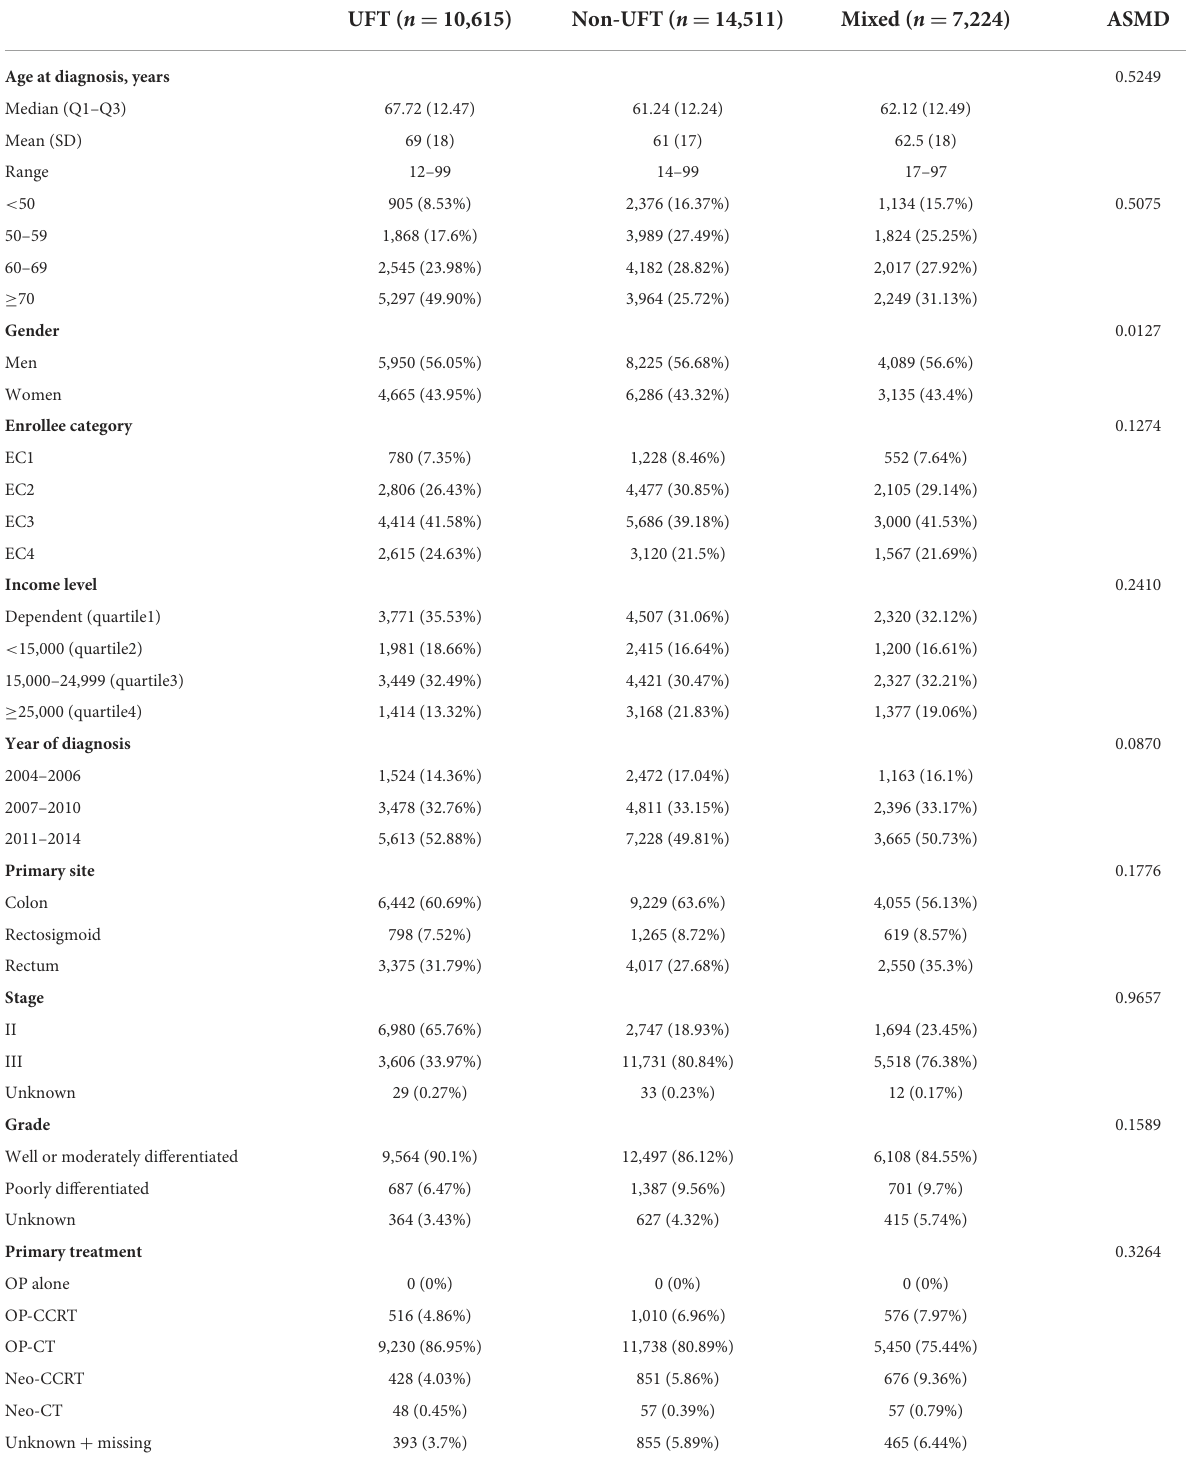
TABLE 1 Demographic, cancer, comorbidity, and medication characteristics among patients with stage II–III colorectal cancer before